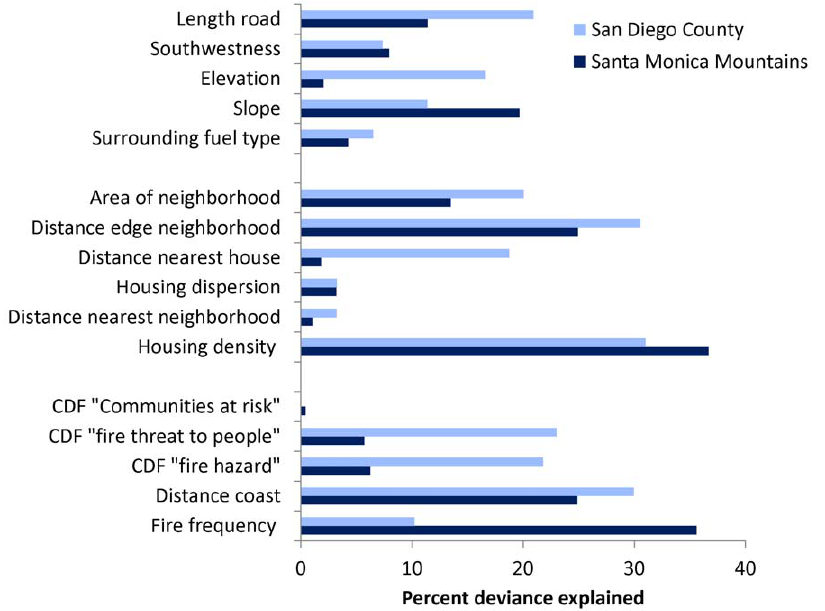
Figure 2. Percent deviance explained for generalized additive models (GAMs). GAMs explain the influence of firefighter access, biophysical variables, structure arrangement, and structure location on burned structures from fires during 2001–2010 in the Santa Monica Mountains, CA and San Diego County, CA. CDF – California Department of Forestry and Fire Protection.